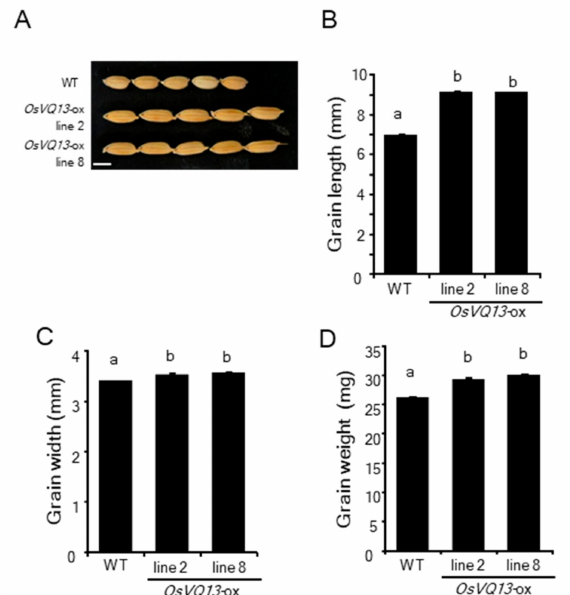
Figure 6. Grain size of OsVQ13 -overexpressing rice plants. ( A ) Mature grains of the WT and OsVQ13 -overexpresing rice plants ( OsVQ13 -ox: lines 2 and 8). Bar = 5 mm. The average grain length ( B ), width ( C ), and grain weight ( D ) of the WT and OsVQ13 -ox plants. Values are means ± SE. Data were analyzed using Tukey’s HSD test ( n = 100 for each genotype). Bars with di ff erent letters are significantly di ff erent at p <